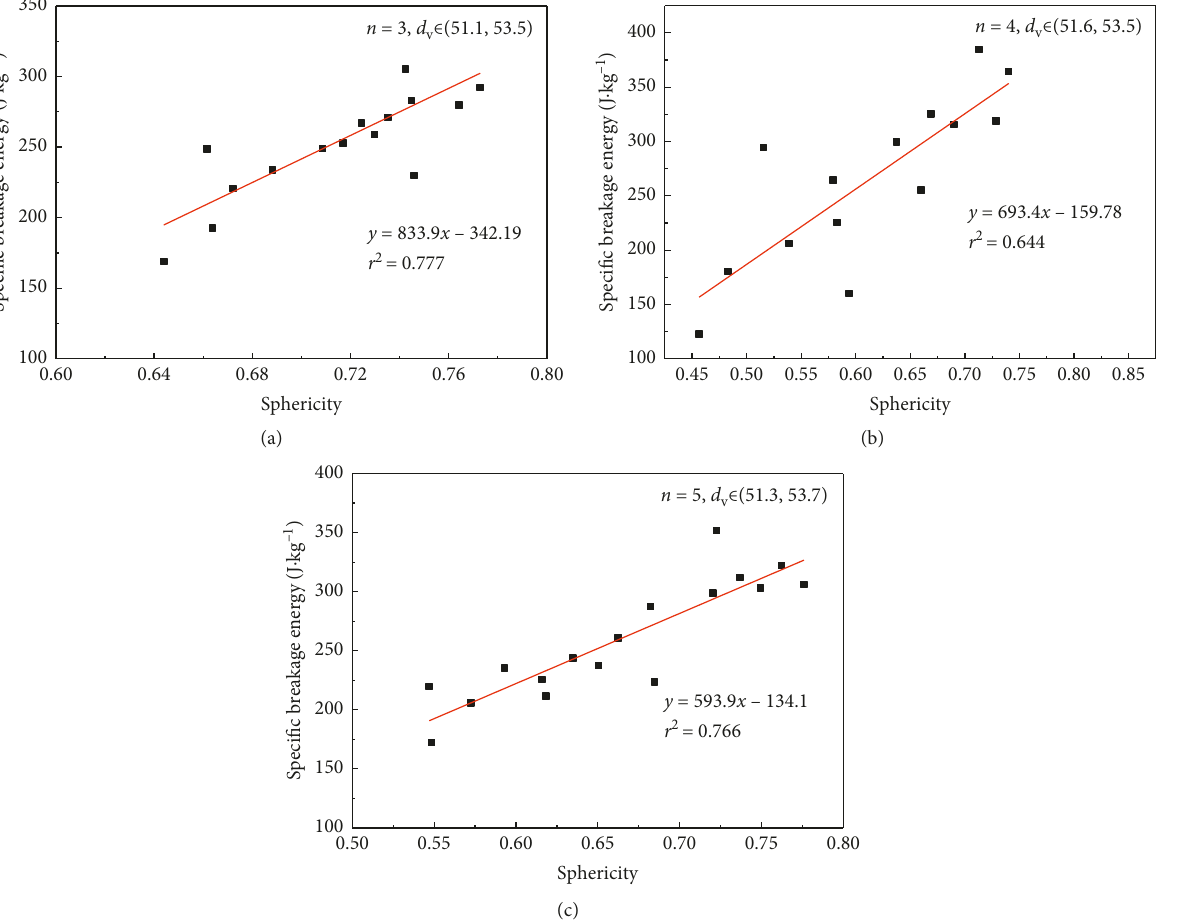
Figure 11: Relationship between specific breakage energy and